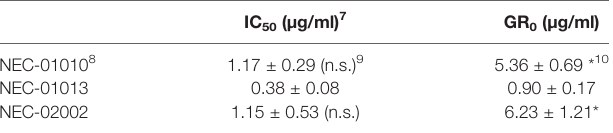
TABLE 4 | Cytotoxicity of cisplatin on NEC organoid lines.